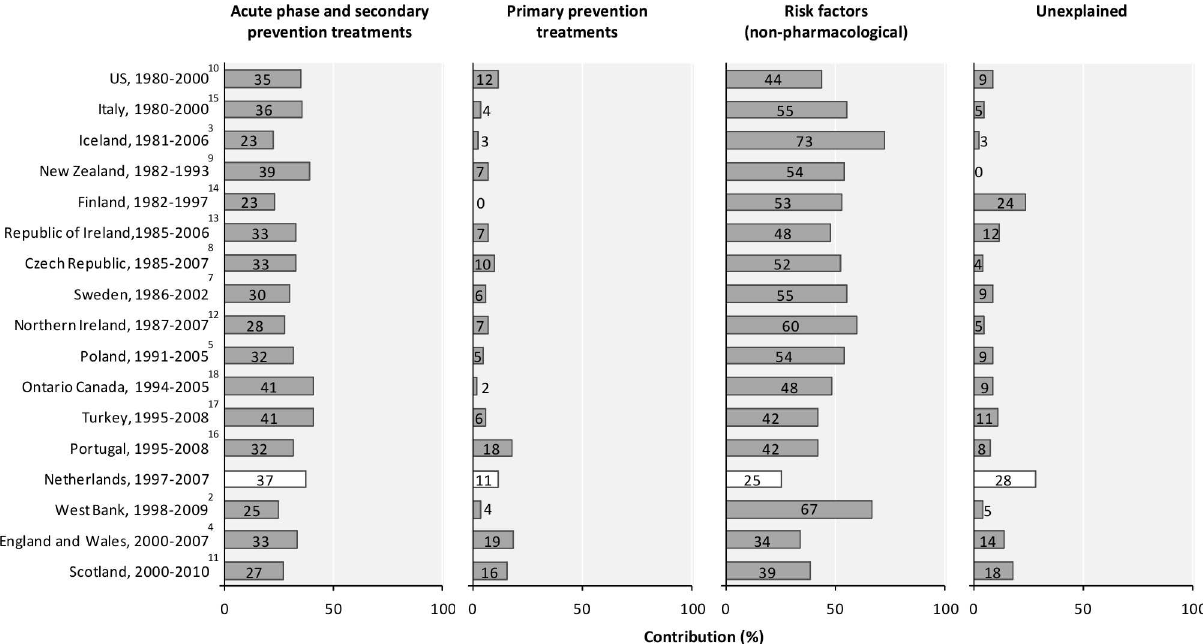
Fig 1. Percentage of the decreasein deaths from coronary heart disease attributed to changes in acute phase and secondary prevention treatments, primary prevention treatments and non-pharmacological risk factor changes in our study population and in other populations. Studies are rankedby starting